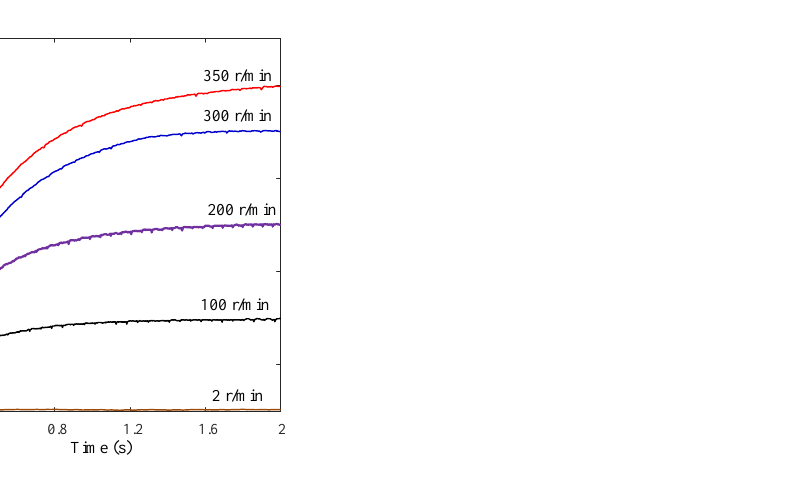
Figure 14. Measured step-input speed responses at different commands.